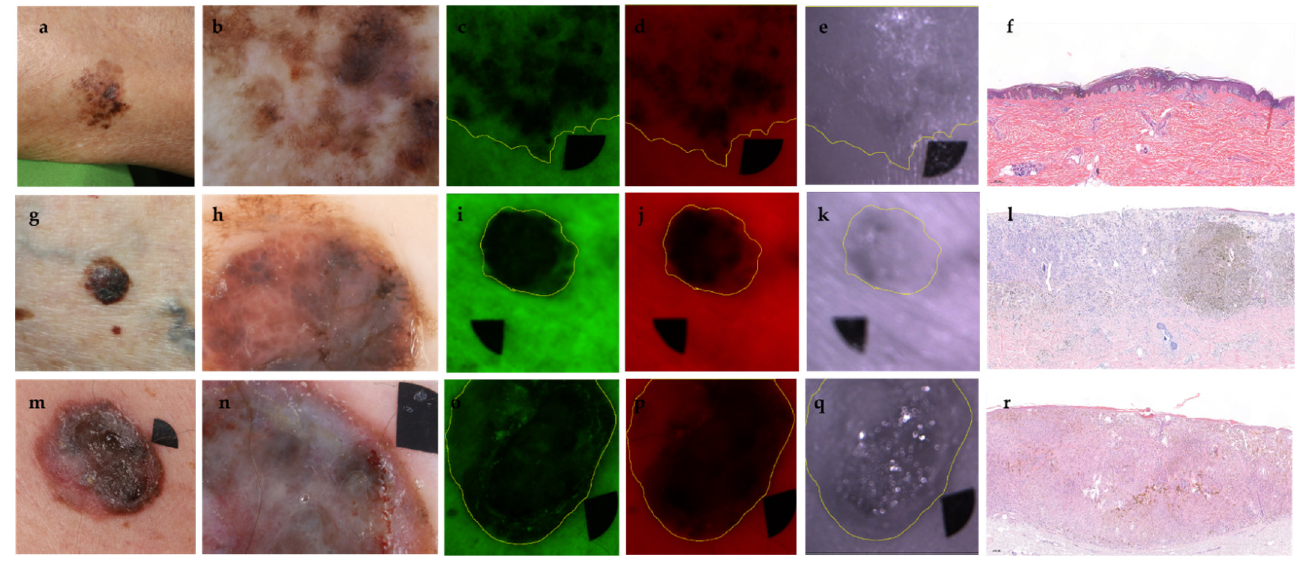
Figure 1. Representative images of melanomas with different Breslow thicknesses. Upper row ( a – f ); melanoma with Breslow 0.345 mm, pT1a, Clark II, superficial spreading melanoma (SSM), clinical photograph ( a ), dermoscopic image ( b ), G ( c ), R ( d ), and IR ( e ) channels and histological image ( f ). Middle row ( g – l ); melanoma with Breslow 1.81 mm, pT2a, Clark IV, SSM, clinical photograph ( g ), dermoscopic image ( h ), G ( i ), R ( j ), and IR ( k ) channel, histological image ( l ). Lower row ( m – r ); melanoma with Breslow 2.42 mm, pT3b, Clark IV, SSM with a nodular component, clinical photograph ( m ), dermoscopic image ( n ), G ( o ), R ( p ), and IR ( q ) channels and histological image ( r ). Black markers (area: 0.125 cm 2 ) are used for image alignment. Histology magnification 51X ( f ) and 50X ( l,r ) (H&E staining).